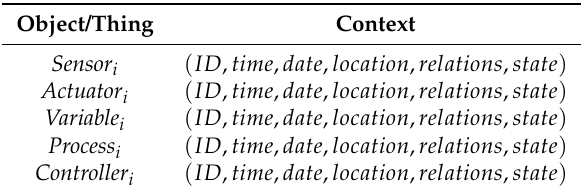
Table 3. Things context designed in smart control